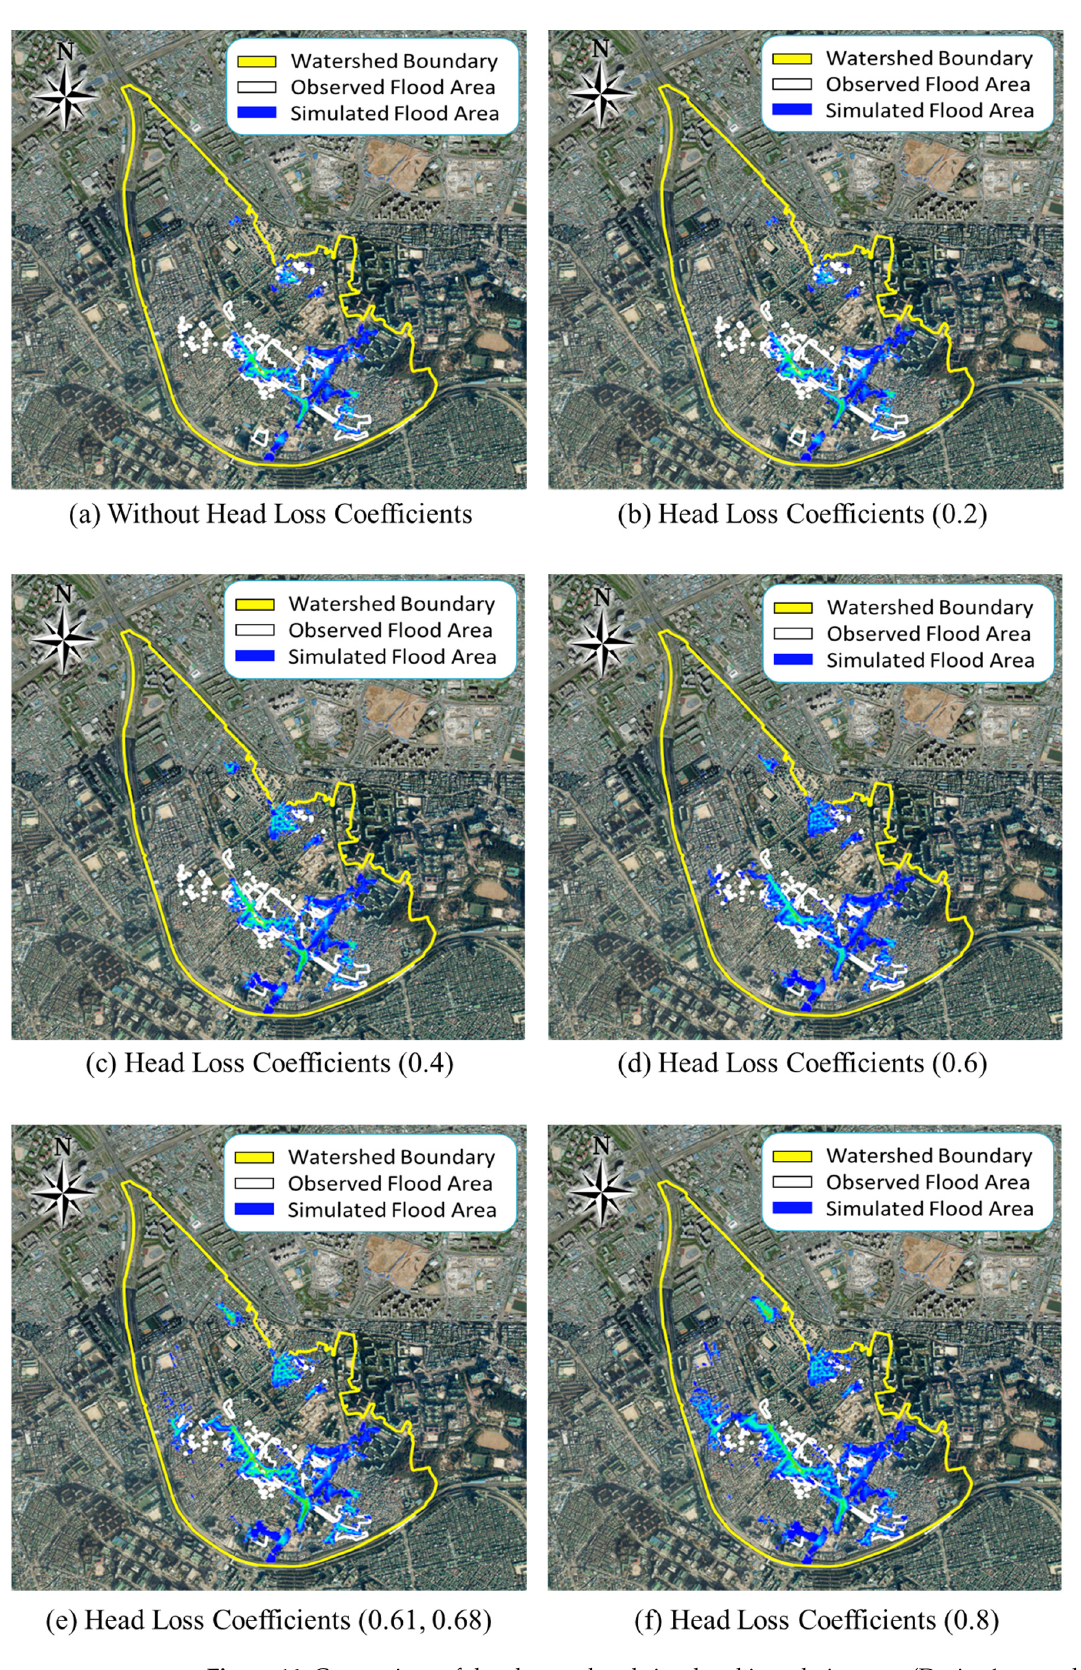
Figure 14. Comparison of the observed and simulated inundation area (Dorim 1 watershed).